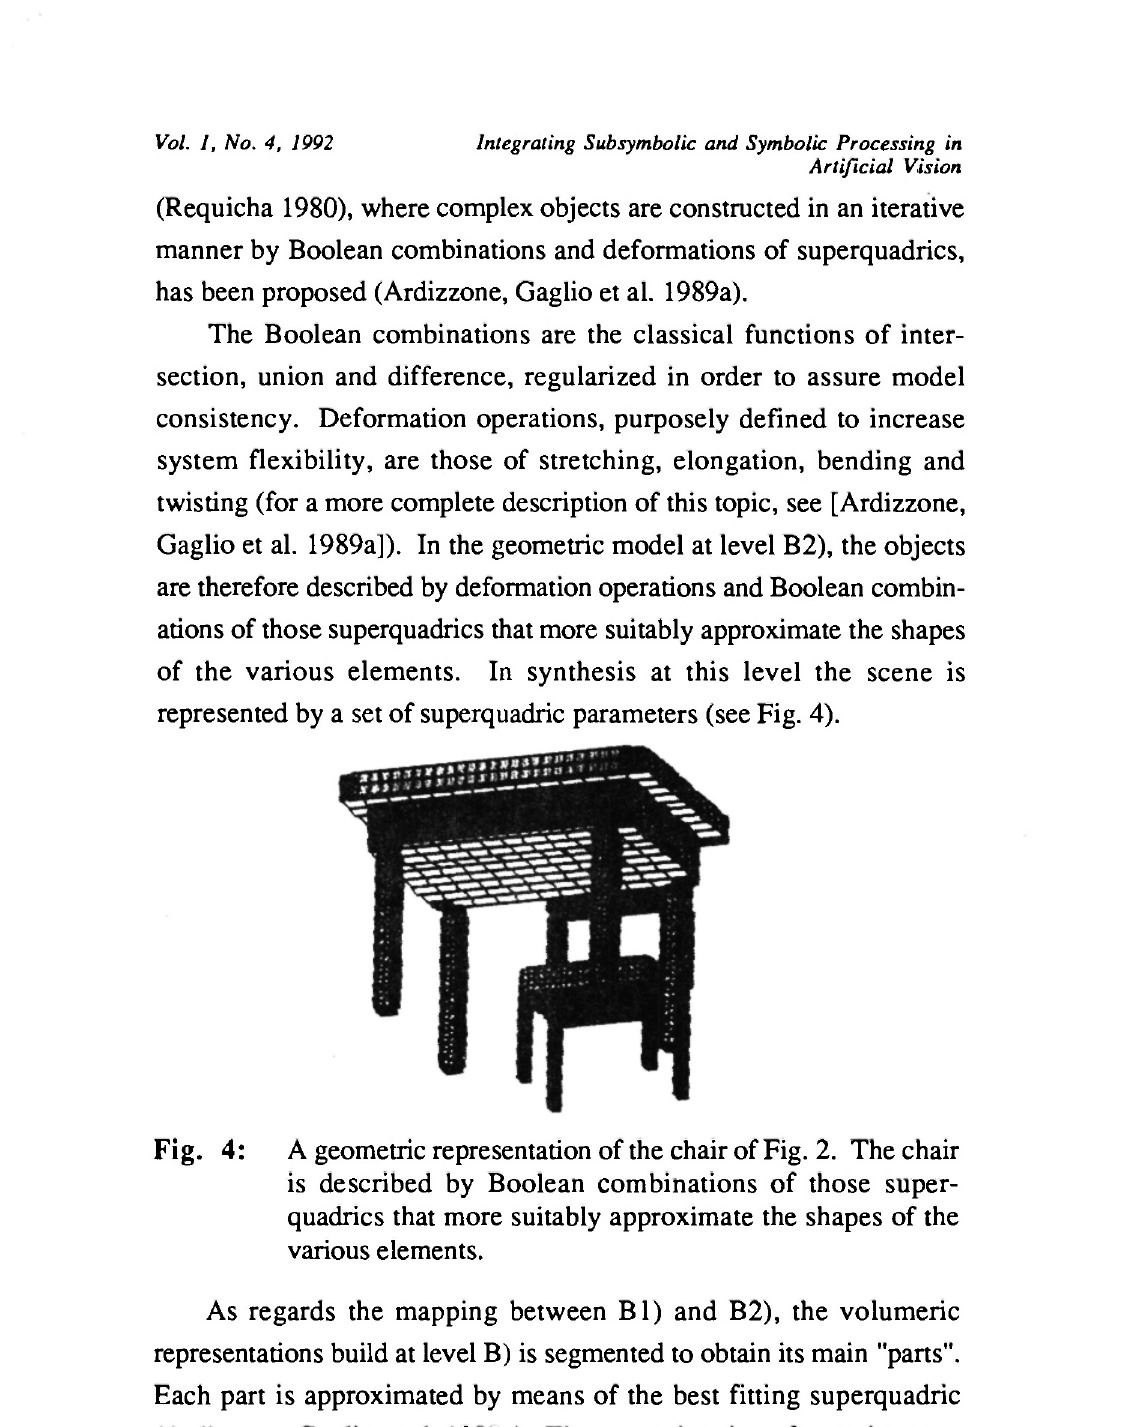
A geometric representation of the chair of Fig. 2. The chair is described by Boolean combinations of those super- quadrics that more suitably approximate the shapes of the various